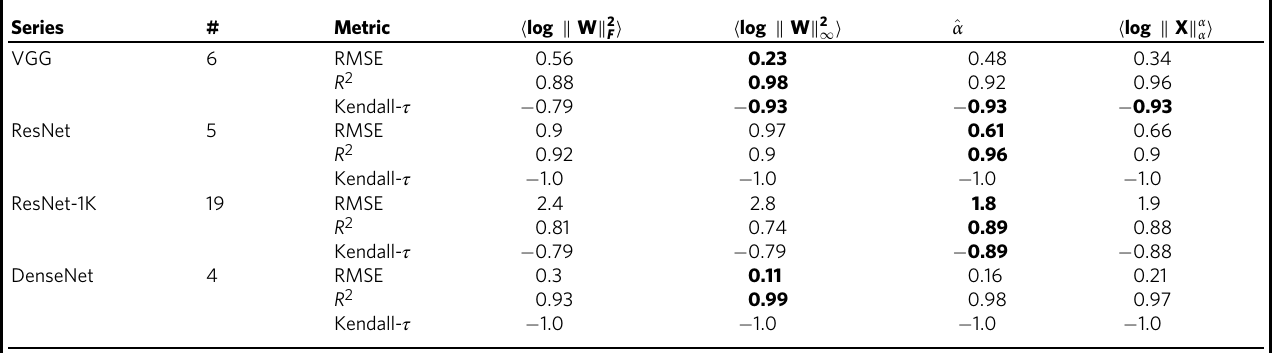
Table 1 Quality metrics (for RMSE, smaller is better; for R 2 , larger is better; for Kendall- τ rank correlation, larger magnitude is better; best is bold) for reported Top1 test error for pretrained models in each architecture